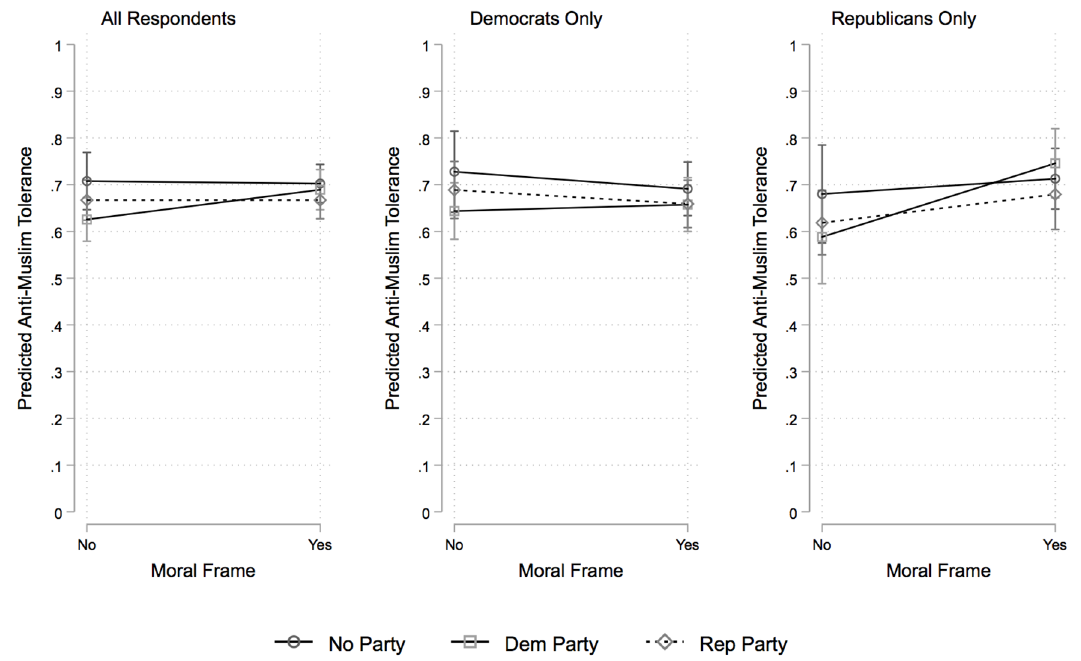
Figure 4. Experimental treatment effects of anti-Muslim tolerance (Study 2). Note. Open dots represent the estimated predicted values for tolerance of speech in each of the anti-Muslim speech conditions plus control condition, with 95% confidence interval bars. All estimates are derived from OLS regression models that employ a factorial design (see Table 2). Estimates for "All Respondents" are derived from the 2x3 factorial design without demographic controls estimated in Table 2, Column 3. Estimates for "Democrats Only" and "Republicans Only" are derived from the 2x3x2 factorial design without demographic controls estimated in Table 2, Column